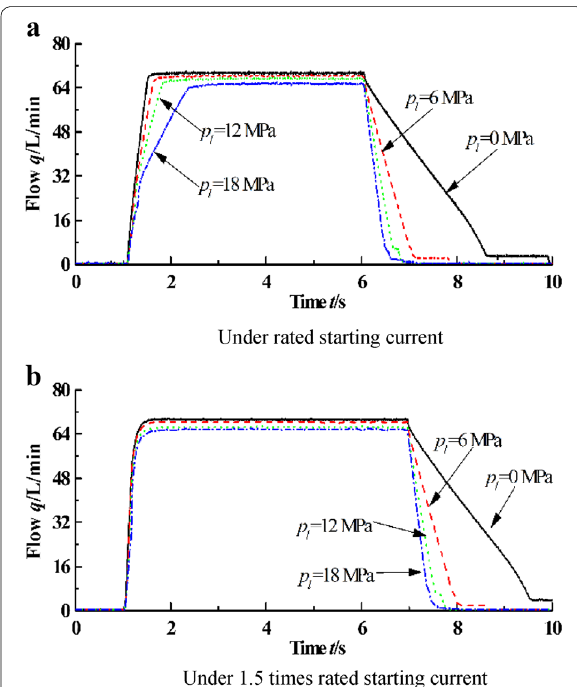
Figure 4 Pump displacement response under command value step